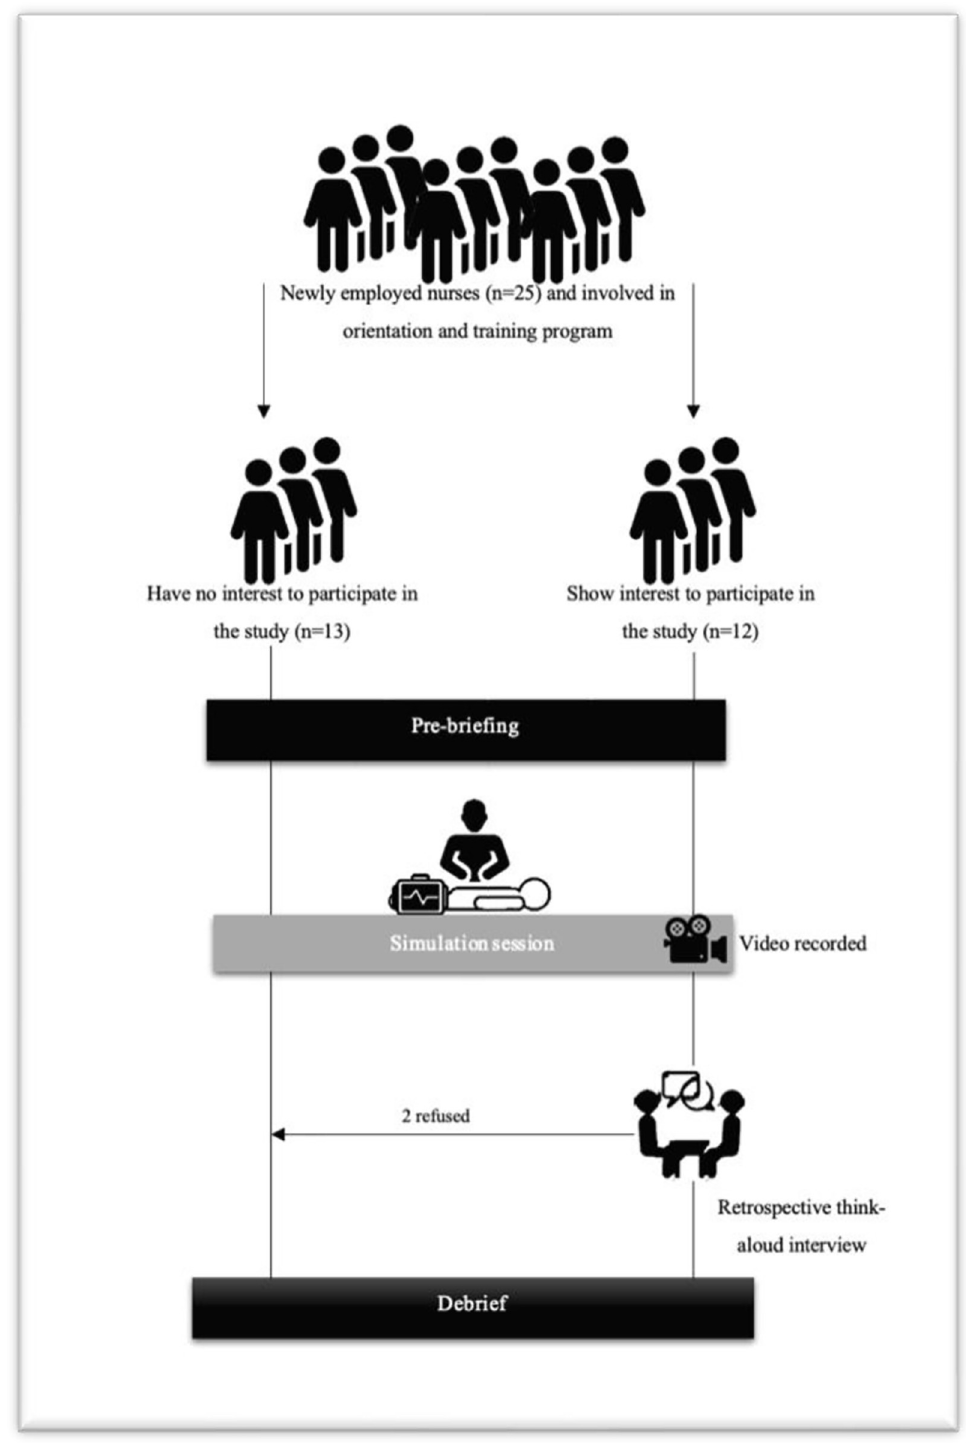
Fig 1. Study recruitment and